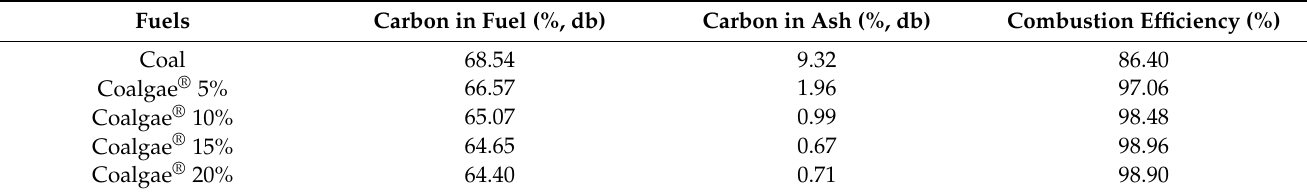
Table 2. Content of carbon in ash and combustion efficiency.